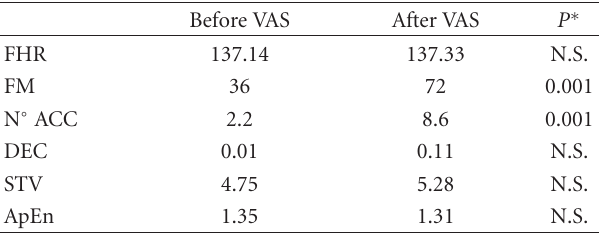
Table 4: FHR parameters before and after VAS in high-risk pregnancies ( n =